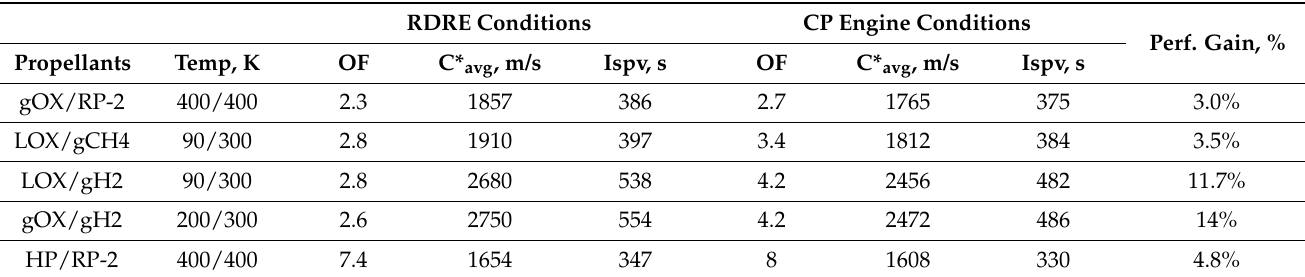
Table 1. Optimal mixture ratios and performance comparison with constant pressure (CP) combustion engine for numerous RDRE propellant combinations, CTAP = 10 atm, ε = 100. CP Engine